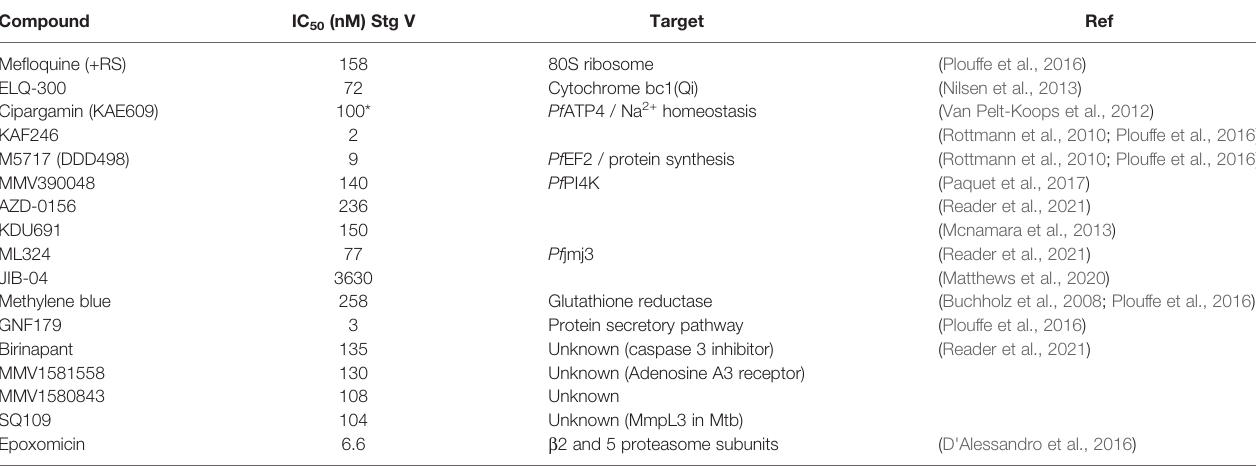
TABLE 2 | Summary of key antimalarials, front-runner and development compounds as well as investigative hits with in vitro activity (< 5 µM) against P. falciparum mature gametocytes.